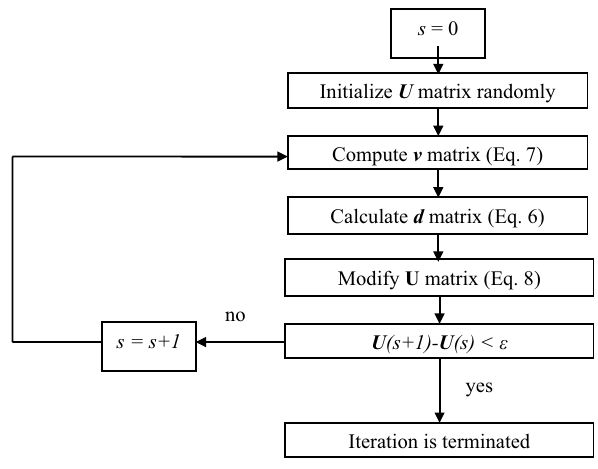
Fig. 3 Flow Chart for fuzzy c-mean